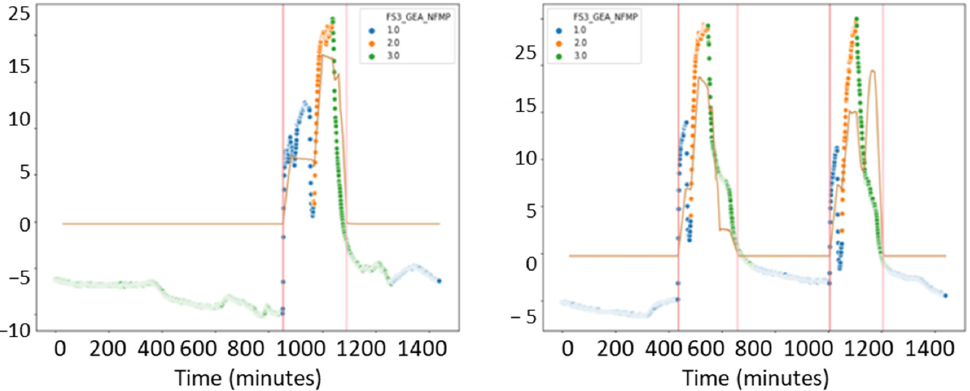
Figure 7. Batches produced per day. One batch ( left ); two batches ( right ).